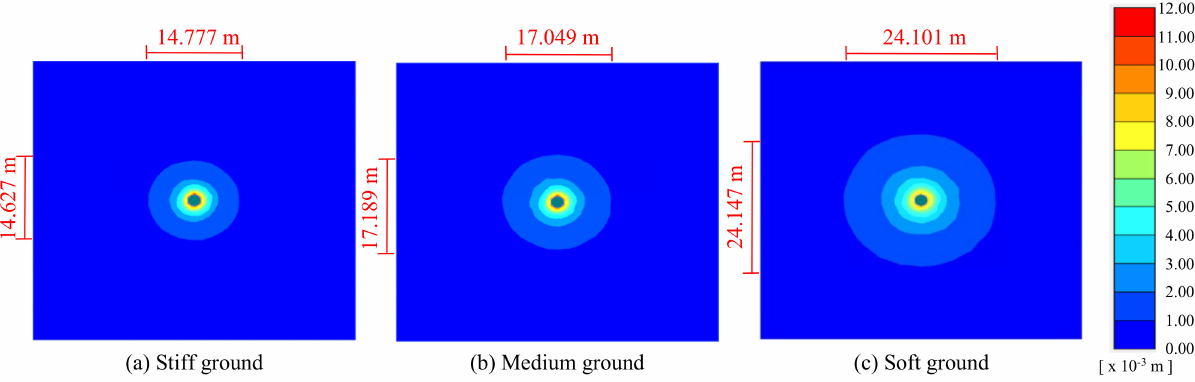
Figure 2. Top views of displacement contour for single boreholes left vacant.